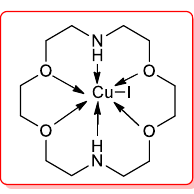
/ C22 catalyst for acylation of terminal Figure 8. CuI/C22 catalyst for acylation of terminal alkynes. Figure 8. CuI